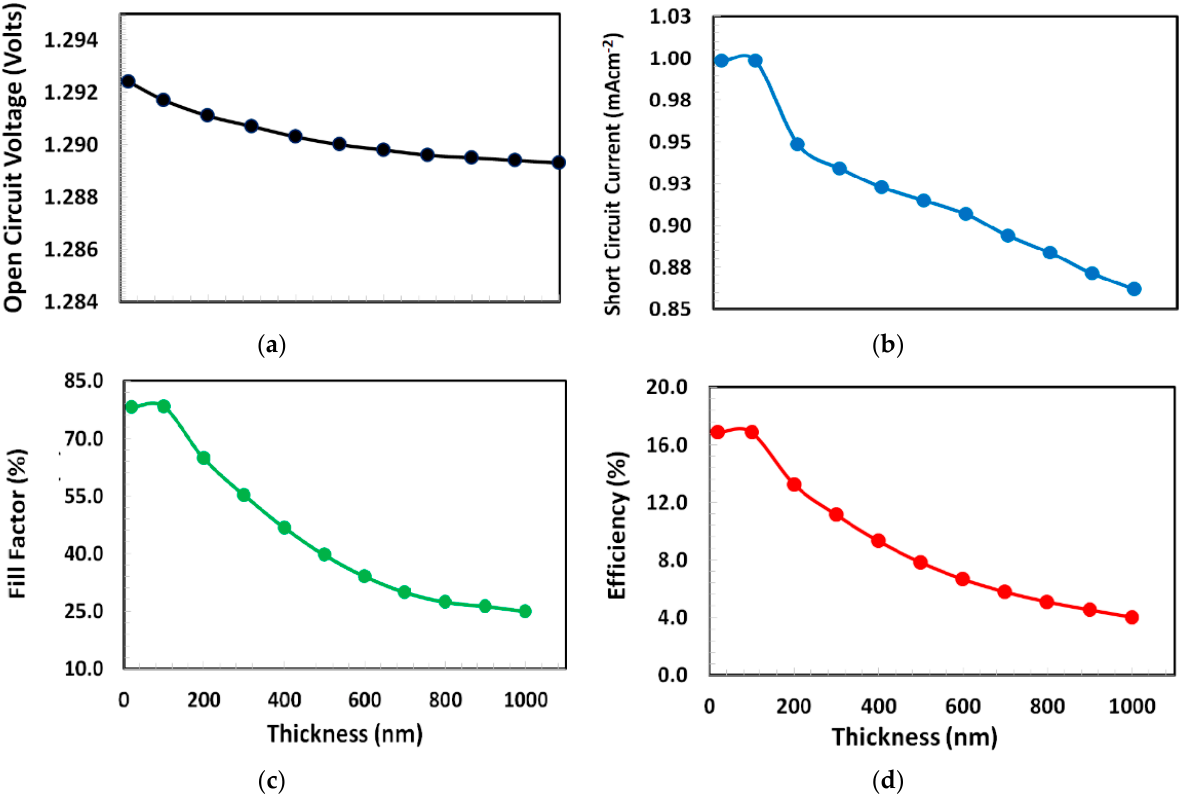
Figure 3. ( a ) Open-circuit voltage, ( b ) short-circuit current, ( c ) fill-factor, and ( d ) power-conversion efficiency of proposed solar cell Ag/BCP/PCBM/Cs 2 TiBr 6 /NPB/ITO as a function of NPB layer thickness varied from 10 to 1000 nm.